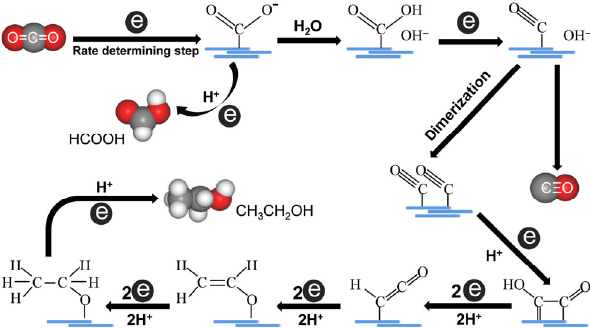
Figure 5 Electrochemical reaction mechanism. Electrochemical reaction mechanism for the formation of carbonaceous compounds on CuO x - NWF@Cu-F electrode during electrocatalytic CO 2